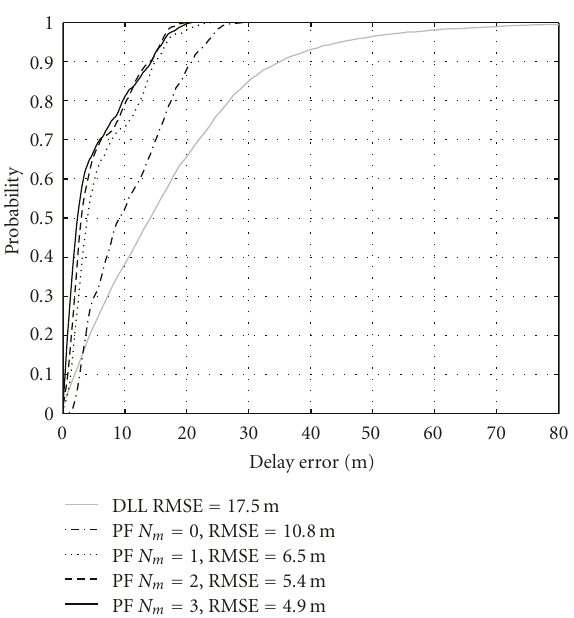
Figure 4: Cumulative normalized histogram of the LOS delay estimation error of the Bayesian approach in comparison with a conventional narrow correlator DLL. Already without considering multipath, the advanced approach is significantly superior. Con- sidering more simultaneously echoes (via N m ) leads to a further improved performance, which tends to saturate rapidly for more than one additional